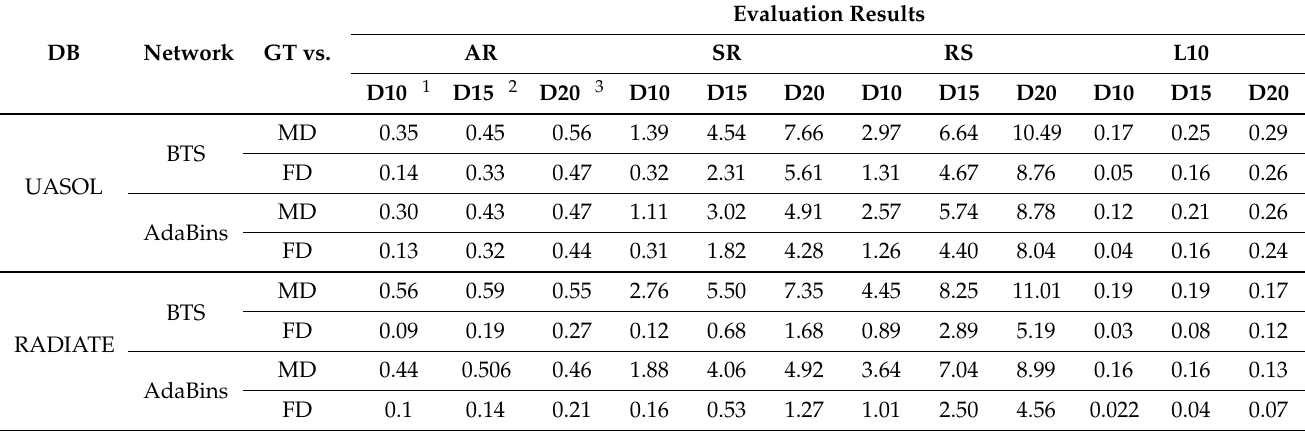
DB Network GT vs.